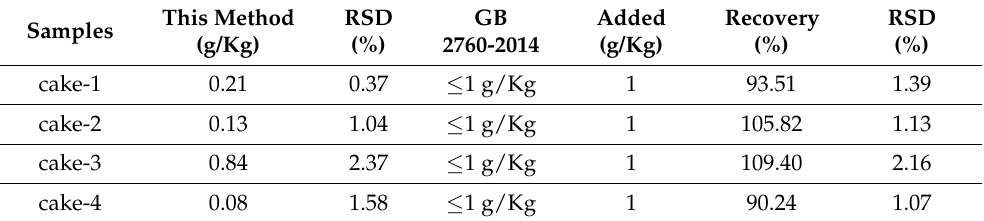
Table 1. The results of SA count with the nanoreactor-based sensing